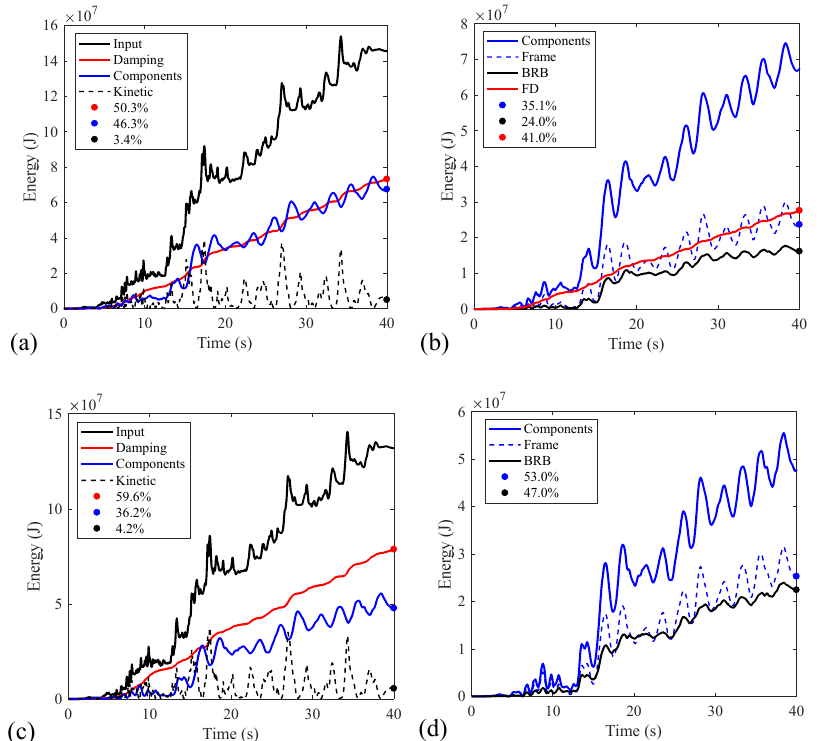
Figure 18. Seismic‑energy analysis (Imperial Valley‑06 case, PGA = 620 cm/s 2 ): ( a ) energy composi‑ Figure 18. Seismic ‐ energy analysis (Imperial Valley ‐ 06 case, PGA = 620 cm/s 2 ): ( a ) energy composi ‐ tion time‑histories (FBRB‑BF); ( b ) energy dissipated by the components (FBRB‑BF); ( c ) energy com‑ tion time ‐ histories (FBRB ‐ BF); ( b ) energy dissipated by the components (FBRB ‐ BF); ( c ) energy com ‐ position time‑histories (BRB‑BF); and ( d ) energy dissipated by the components (BRB‑BF). position time ‐ histories (BRB ‐ BF); and ( d ) energy dissipated by the components (BRB ‐ BF).